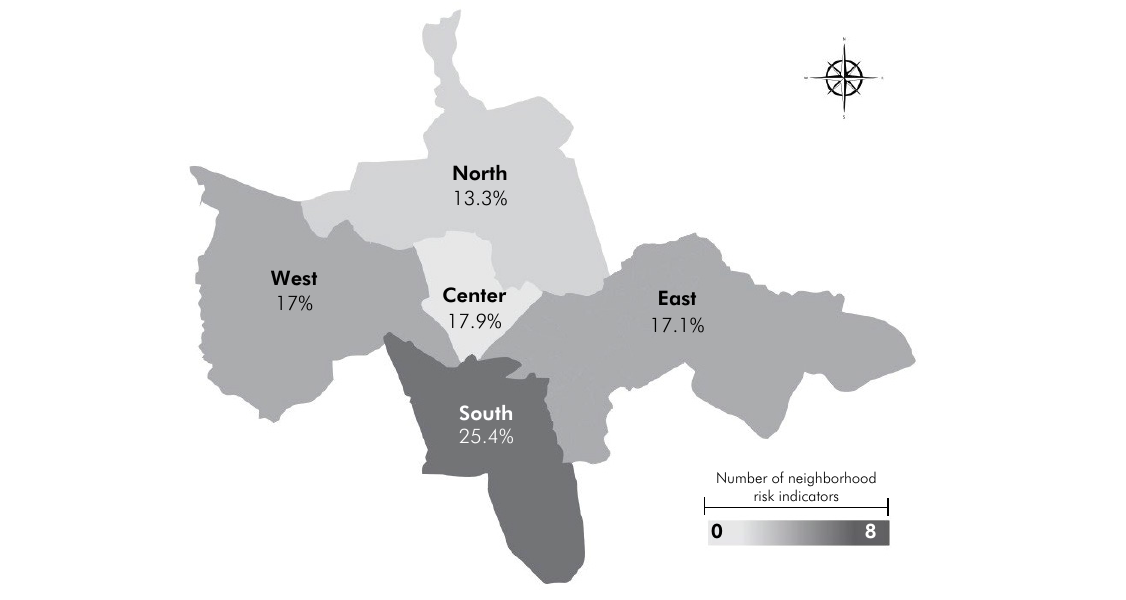
Figure 3. City map illustrating the prevalence of TDI in the different regions of the city, Santa Maria, southern